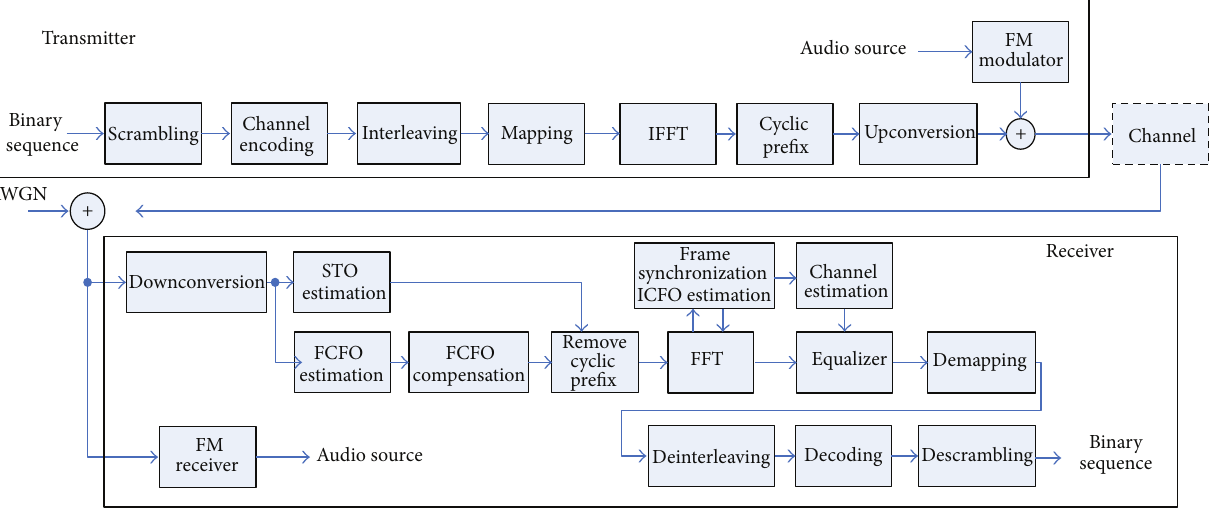
Figure 2: HD radio FM transceiver block diagram.